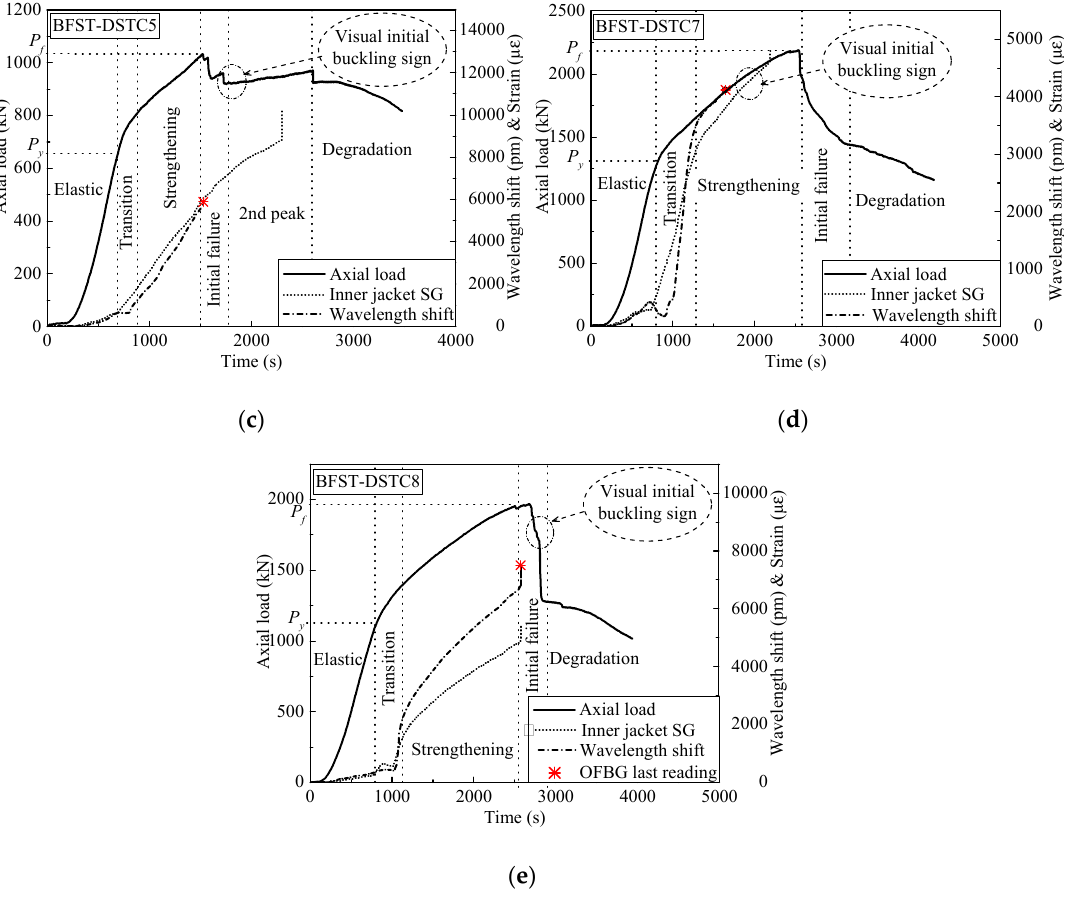
Figure 10. Inner tube self-sensing response based on accumulated WS for specimen: ( a ) BFST-DSTC2; ( b ) BFST-DSTC3; ( c ) BFST-DSTC5; ( d ) BFST-DSTC7; ( e ) BFST-DSTC8.